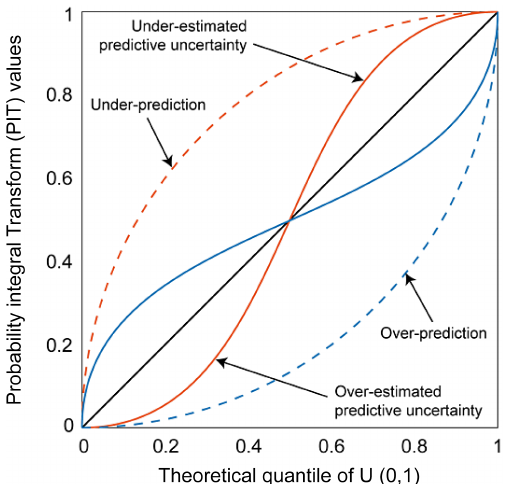
Figure 4. Possible interpretations of PIT plots (modified from Laio and Tamea, 2007). The diagonal line (in black) represents the ideal